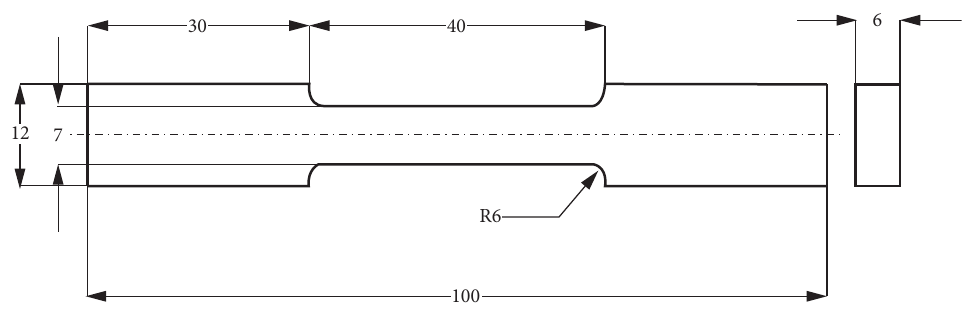
Figure 3: Fabricated AA6061/Si